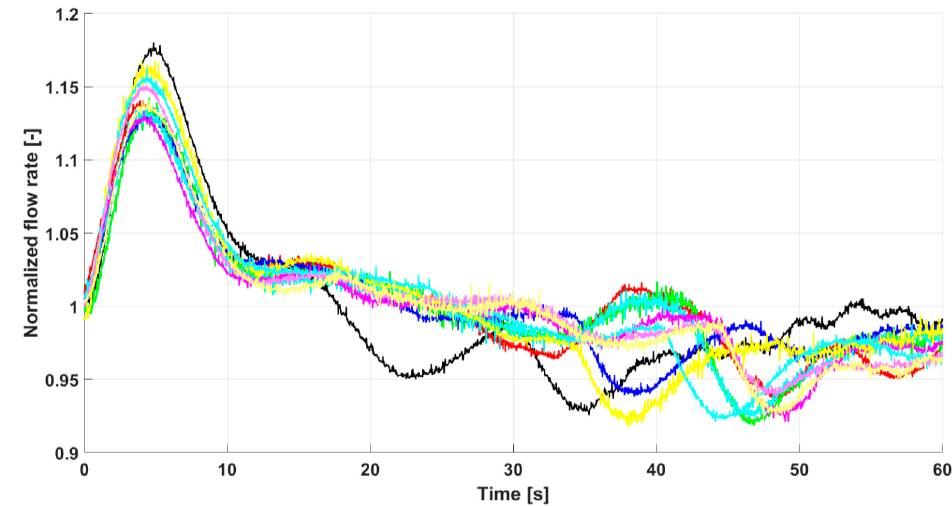
Figure 10. Normalized fluid flow rate versus time from start of displacement for the experiments with the automatic pump control.